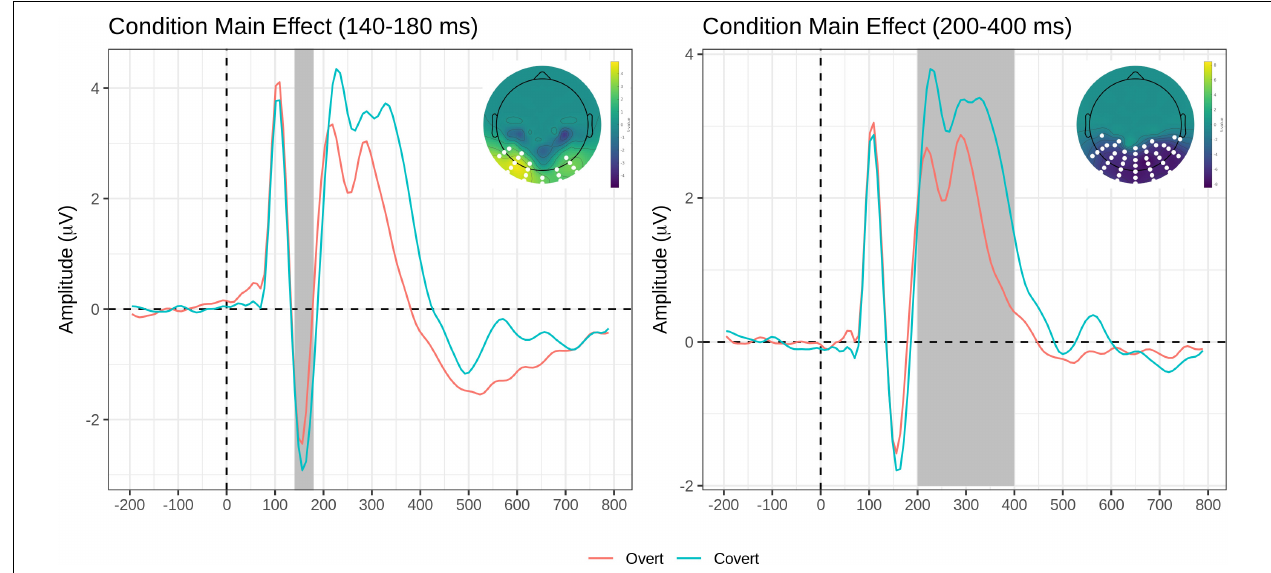
FIGURE 4 | Task main effects for the early time window (140–180 ms, left) and the intermediate time window (200–400 ms, right). On each panel, grand-average waveforms for the Overt (red) and Covert (teal) task for the electrodes included in the significant clusters (highlighted in white on topographical maps); scalp topography of the Overt vs. Covert contrast for the significant clusters (again, the significant electrodes are highlighted in white). The Emotion factor is collapsed.